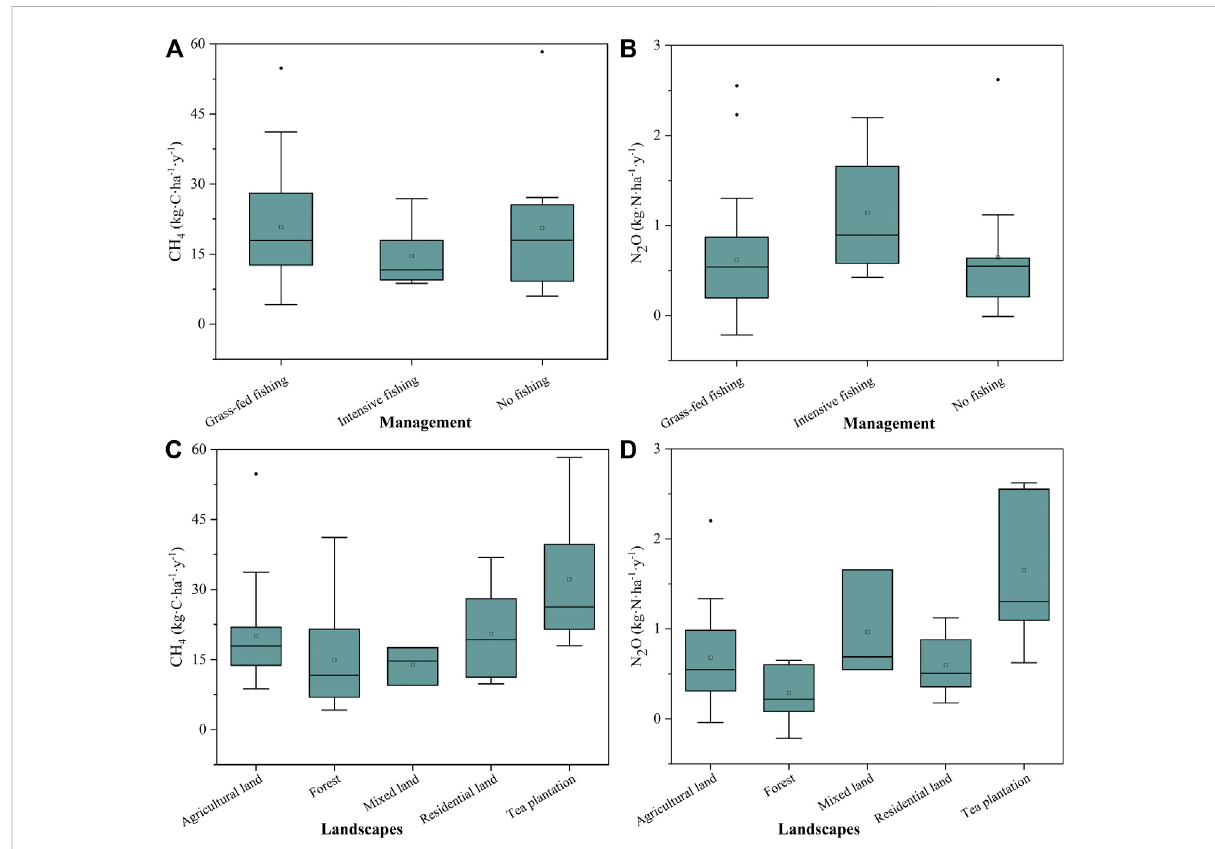
FIGURE 3 Annual CH 4 and N 2 O emissions in different management types (A,B) and landscape types of ponds (C,D)